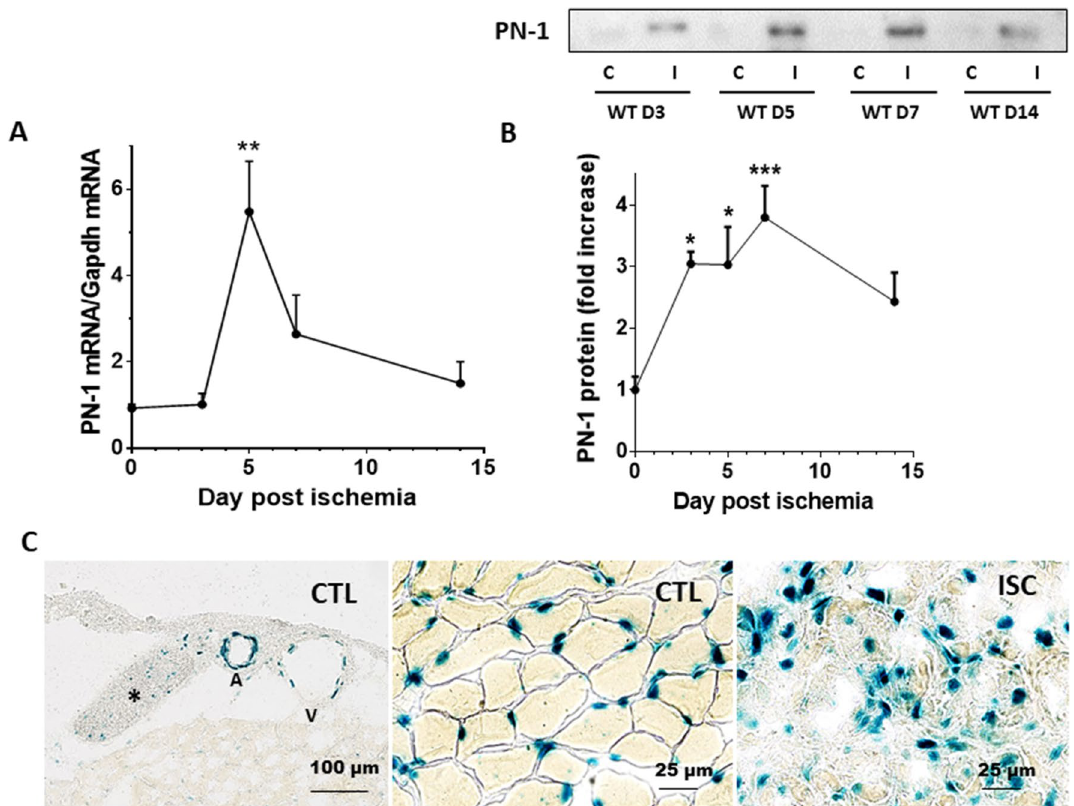
Figure 1. PN-1 muscle expression increases following ischemia. ( A ) Quantification of PN-1 mRNA by qRT-PCR; Anova ** p < 0.01; ( B ) Immunoblotting of muscle lysates with antibody to PN-1 and densitometric analysis; Anova * p < 0.05, *** p < 0.001. The uncropped image is shown in supplementary Fig. S2, ( C ): XGal staining on frozen muscle sections from PN-1/LacZ mice, representative images out of 4; first panel: control muscle * = nerve fibre, A: artery, V: vein; second panel: magnification of control gastrocnemius; third panel: magnification of ischemic gastrocnemius, 7 days after ligation.